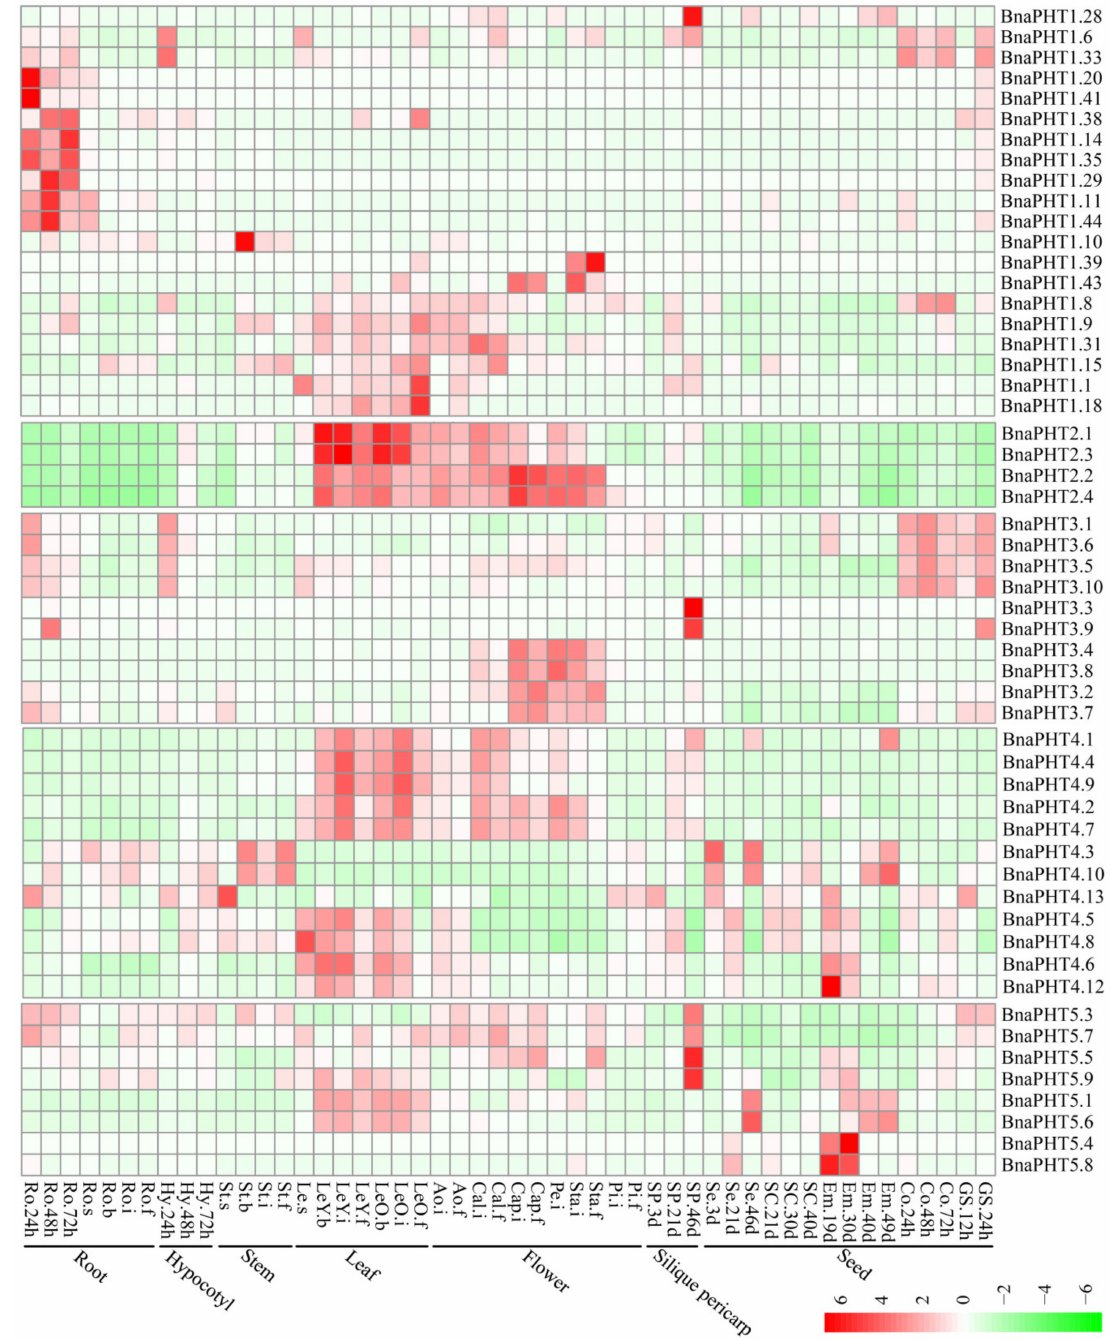
Figure 6. Expression pattern of BnaPHTs in 50 tissues during plant development. Ro = root, St = stem, Le = leaf, Sp = silique pericarp, Sc = seed coat, Em = embryo, Ao = anthocaulus, Se = seed, Hy = hypocotyl, GS = germination seeds, Cap = capillament, Pi = pistil, Cal = calyx, Co = cotyledon, Pe = petal. The “h”, “d”, “i”, “f”, “s” indicate hour, day, seeding, budding, initial flowering, and full-bloom stages, respectively. The BnaPHTs with no or weak expression levels (FPKM < 1) were removed from the heatmap. The color bar at the low right represents log2 expression value (FPKM ≥ 1): green represents low expression, and red represents high